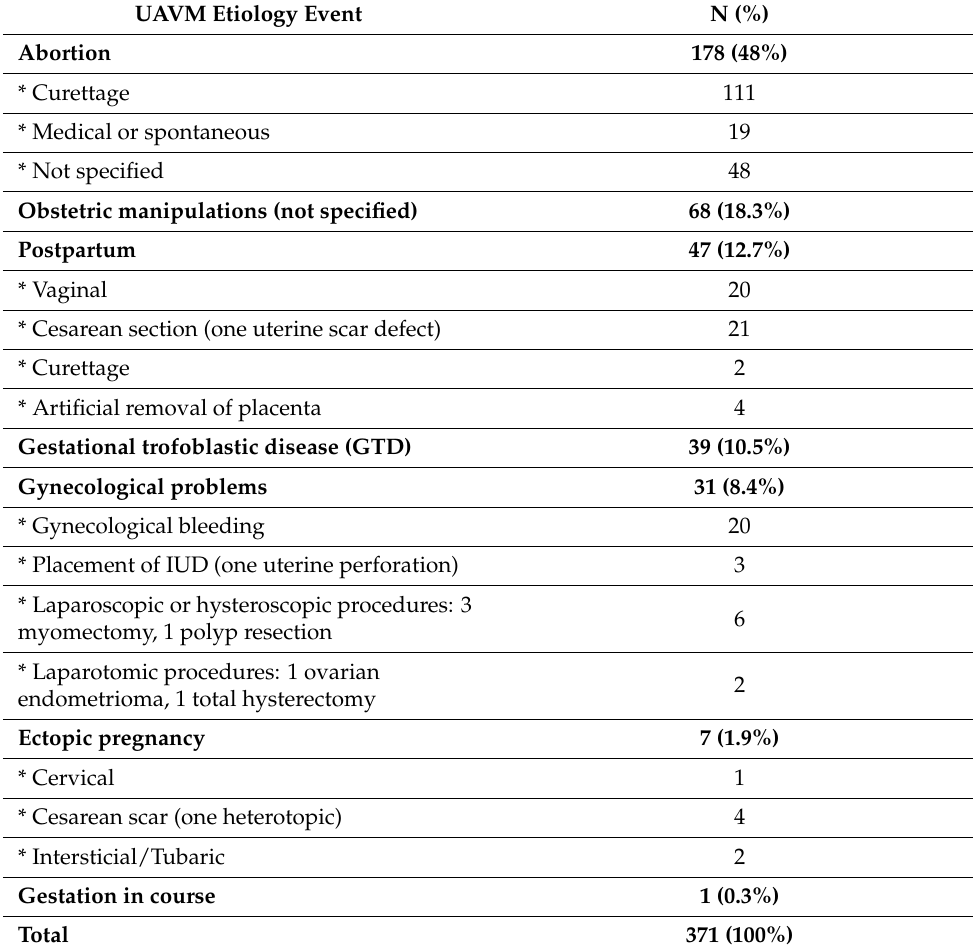
Table 1. Clinical history for reported cases of UAVM.